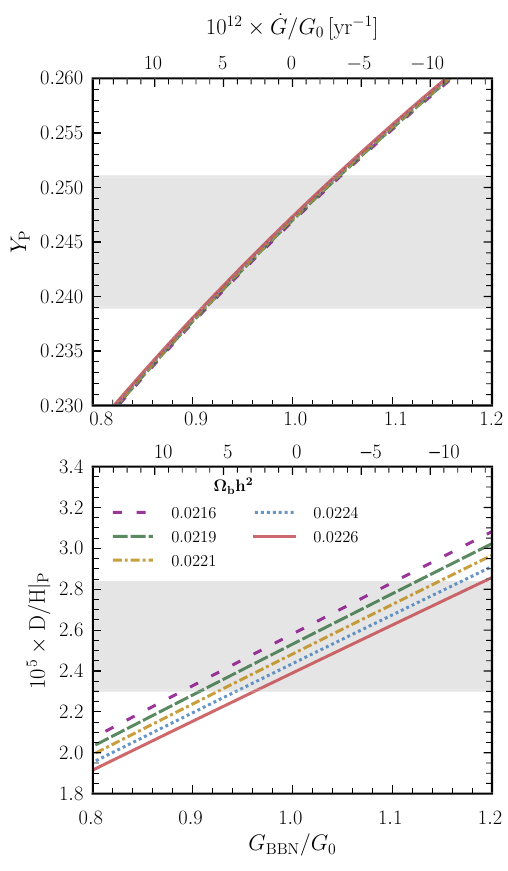
Fig. 1 The variation in the primordial helium abundance (upper) and theprimordialdeuteriumabundance(lower)asafunctionof G BBN / G 0 . The grey bands correspond to the 2 σ confidence intervals from the astrophysical measurements in Eqs. (2) and (3). The different lines correspond to representative values of the baryon density (cid:4) b h